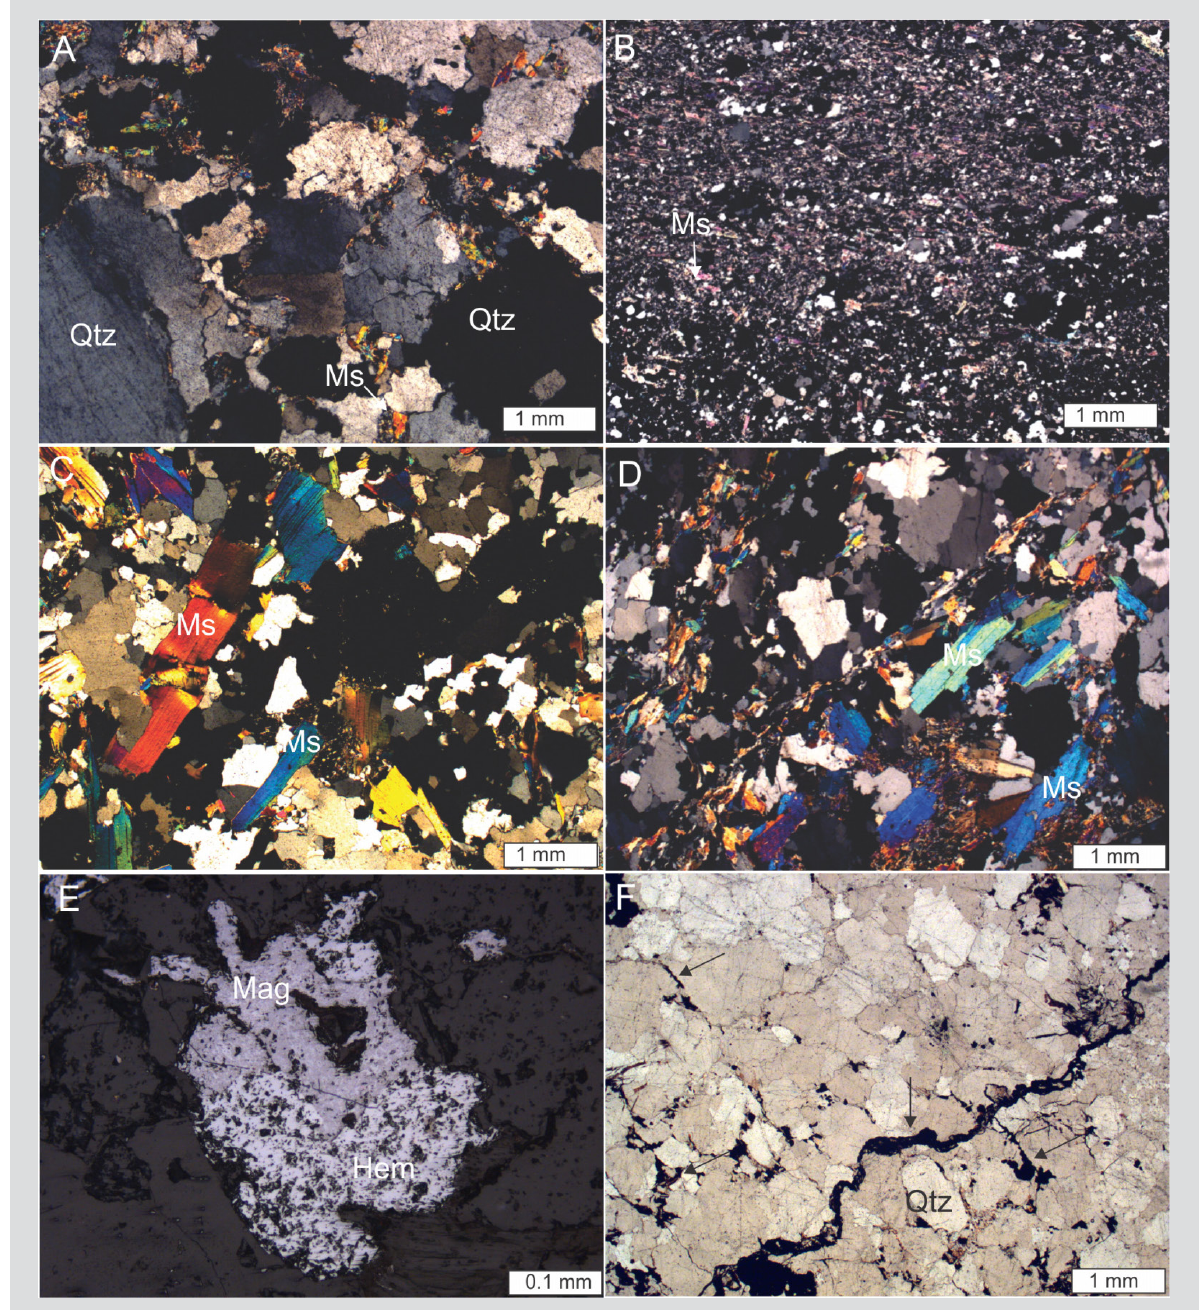
Figure 7 - Microscopic features of metaconglomerates. (A) Coarse-grained quartz-mica matrix with angular and subangular quartz grains showing concave-convex and sutured contacts. (B) Matrix with mylonitic foliation. (C) Coarse-grained, recrystallized white mica with undulose extinction. (D) Oriented crystals of white mica. (E) Hematite substitution of magnetite. (F) Ferruginous cement (arrows) filling primary and secondary porosity. Ms: muscovite (white mica), Qtz: quartz, Hem: hematite, Mag: